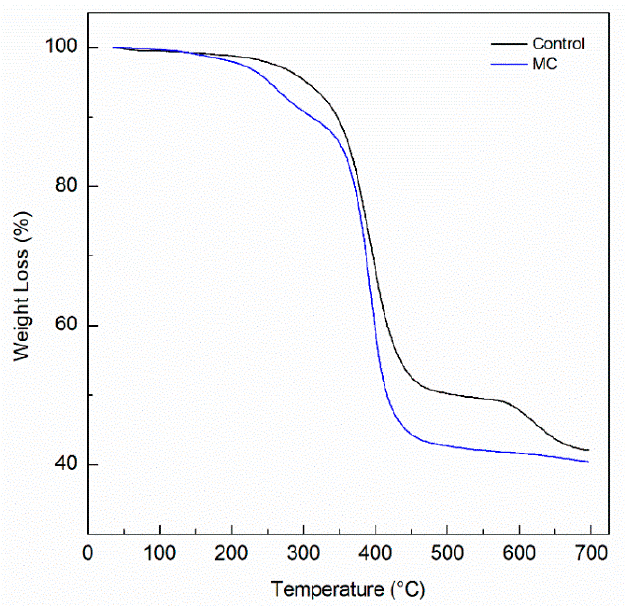
Figure 5. TGA curves for the WA coating control and WA coating doped with colophony microcap- sules.